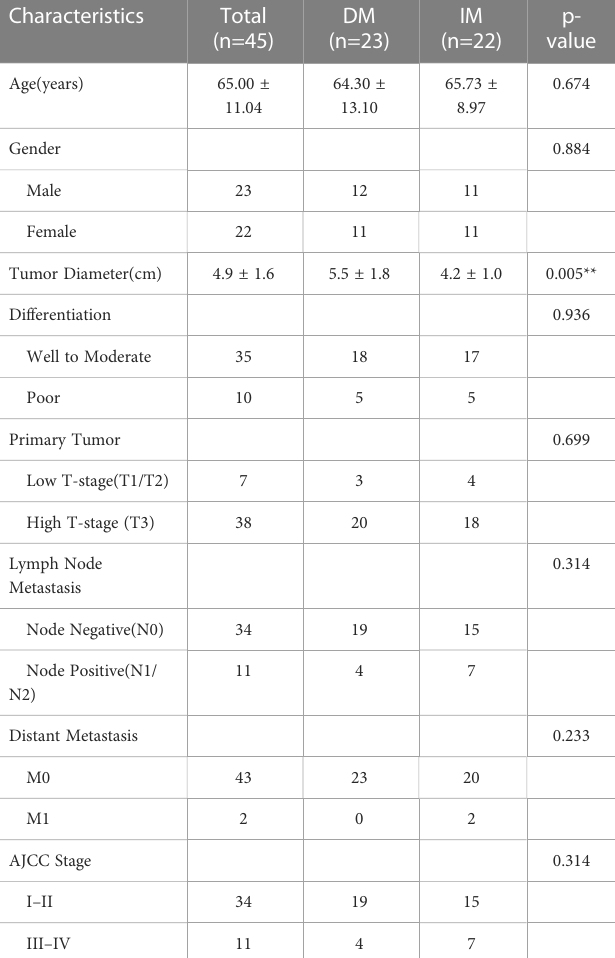
TABLE 2 Clinicopathological features of SCRC patients.